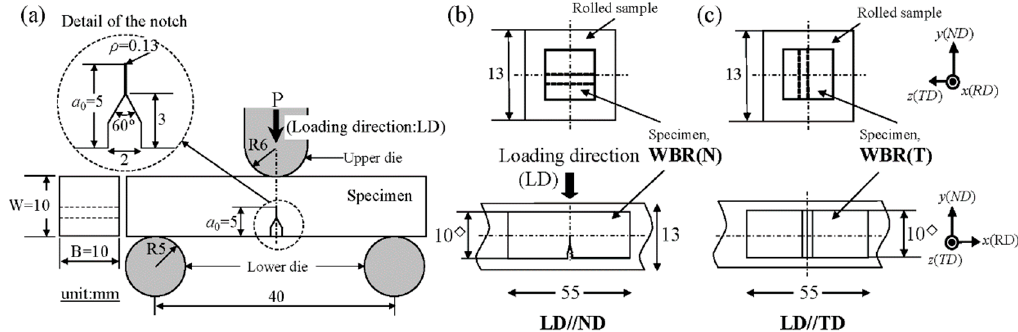
Figure 3. ( a ) Detail of the three-point bending test. ( b , c ) Notch orientation and dimensions of the specimens taken from the WBR sample.